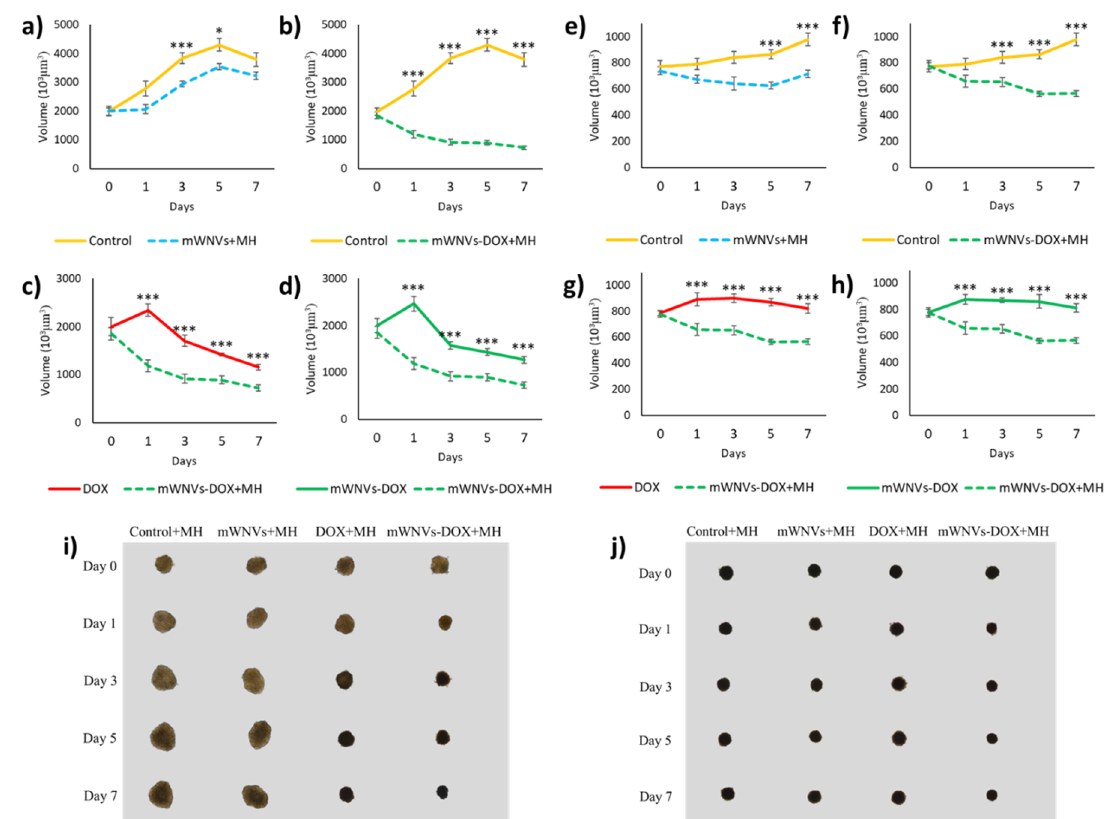
Figure 6. Volume evolution of ( a – d ) B16F10 MCTSs and ( e – h ) Hs578T MCTSs treated with control unloaded mWNVs (blue), control unloaded mWNVs plus MH (blue dotted), mWNV-DOX (green), and mWNV-DOX plus MH (green dotted) measured for 7 days (mean ± SEM; * p < 0.01, *** p < 0.001, Student’s t -test). ( i ) Phase contrast images of B16F10 and ( j ) Hs578T MCTS after 7 days under different treatments.